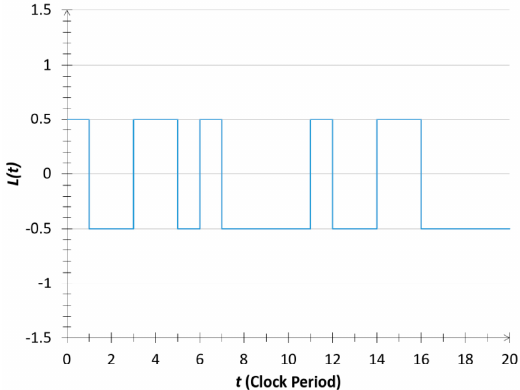
Figure 3. Computer simulation [14] of a random telegraph wave carrying the high-bit value of a noise-bit in the asymmetric instantaneous-noise-based logic (INBL) scheme.